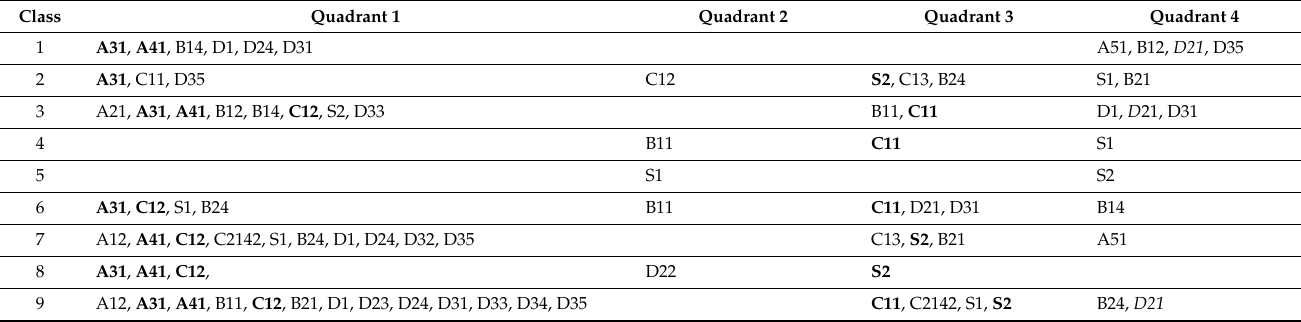
Table 7. Multiple cases: clear expression of emotions (A11) as a focal behavior with category selection as conditioned